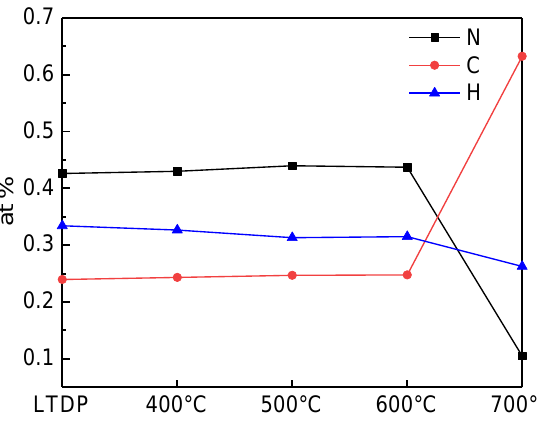
Figure 4. Elemental analysis of LTDP and the samples treated at 5 GPa and 400–700 °C.